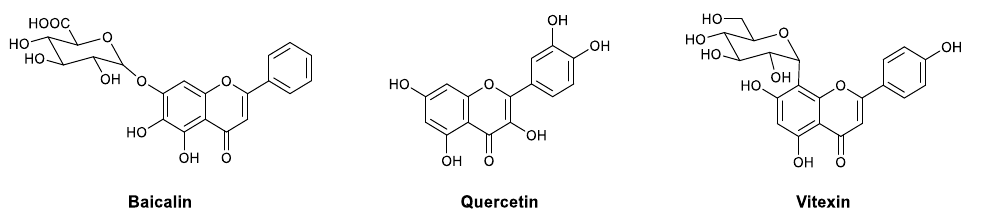
Figure 7. Structures of baicalin, quercetin, and vitexin.